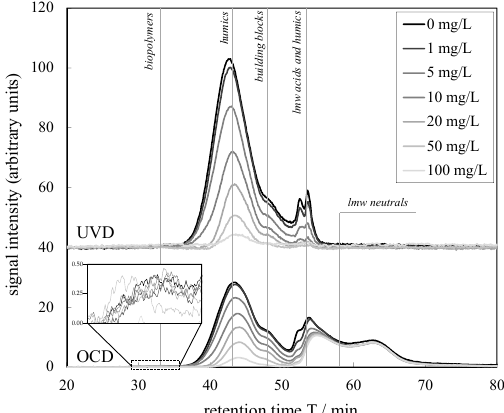
Figure A1. LC-OCD-UVD chromatogram the raw water treated by different concentrations of PAC 2 with corresponding removal of DOC fractions according to Huber et al. (2011) [37] during determination of adsorption isotherms (T = 20 °C, V batch = 200 mL, t R = 72 h @ 150 rpm).